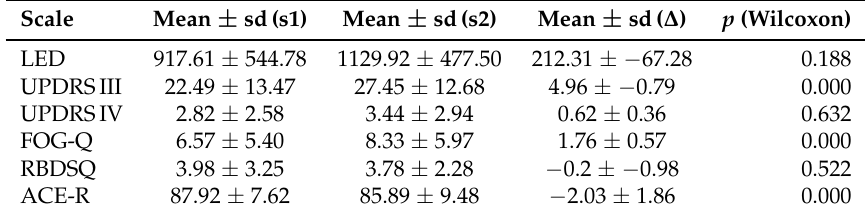
Table 1. Clinical characteristics of the patients.